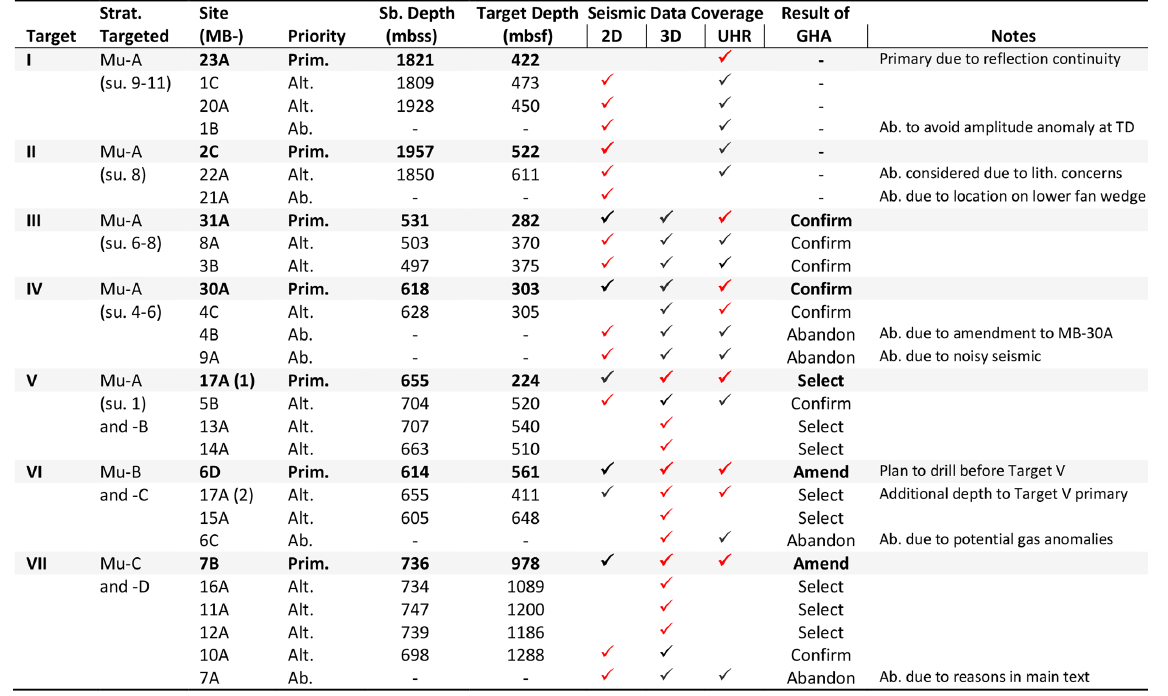
Table 3. A site information table for the active and abandoned sites of IODP Proposal 909. Seismo-stratigraphic units are from Gregersen et al. (2013, 2017) and Knutz et al. (2015) and are shown in Fig. 2. The ticks indicate the seismic data coverage at each site, while the red coloured ticks denote which data were used primarily for initial site selection. The result of the geohazard assessment column signifies the impact the assessment had on that site and includes confirm (site approved after being initially selected on a form of 2D seismic data), amended (site was moved to this location from an abandoned site), select (site was chosen as an initial location) and abandon (site was deemed an unfit location). Abbreviations used include stratigraphy (Strat), sub-unit (su), primary (Prim), alternate (Alt), abandoned (Ab), seabed (sb), metres below sea surface (mbss), metres below seafloor (mbsf), ultra-high-resolution (UHR), geohazard assessment (GHA), lithology (lith) and total depth (TD). All site locations are shown in Fig.